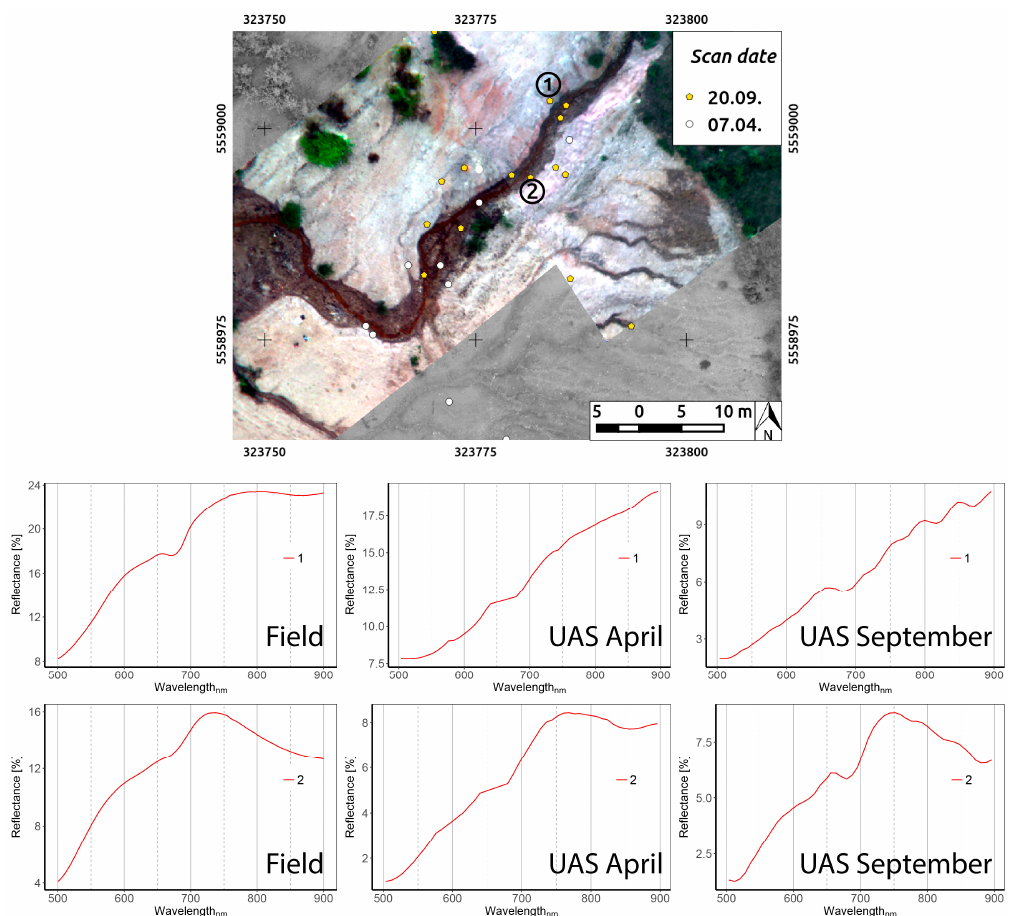
Figure 10. Extracted spectra from UAS-borne HSIs displayed in the two rows below the overview map. The first column (field) depicts a ground spectrum, juxtaposed to it are two spectra extracted from the same location, taken from ROIs of only several pixels. The corresponding spots are marked in the map as numbers 1 and 2 , respectively. The white and yellow points indicate ground truth measurements (pH, field spectroscopy, sampling for iron content).